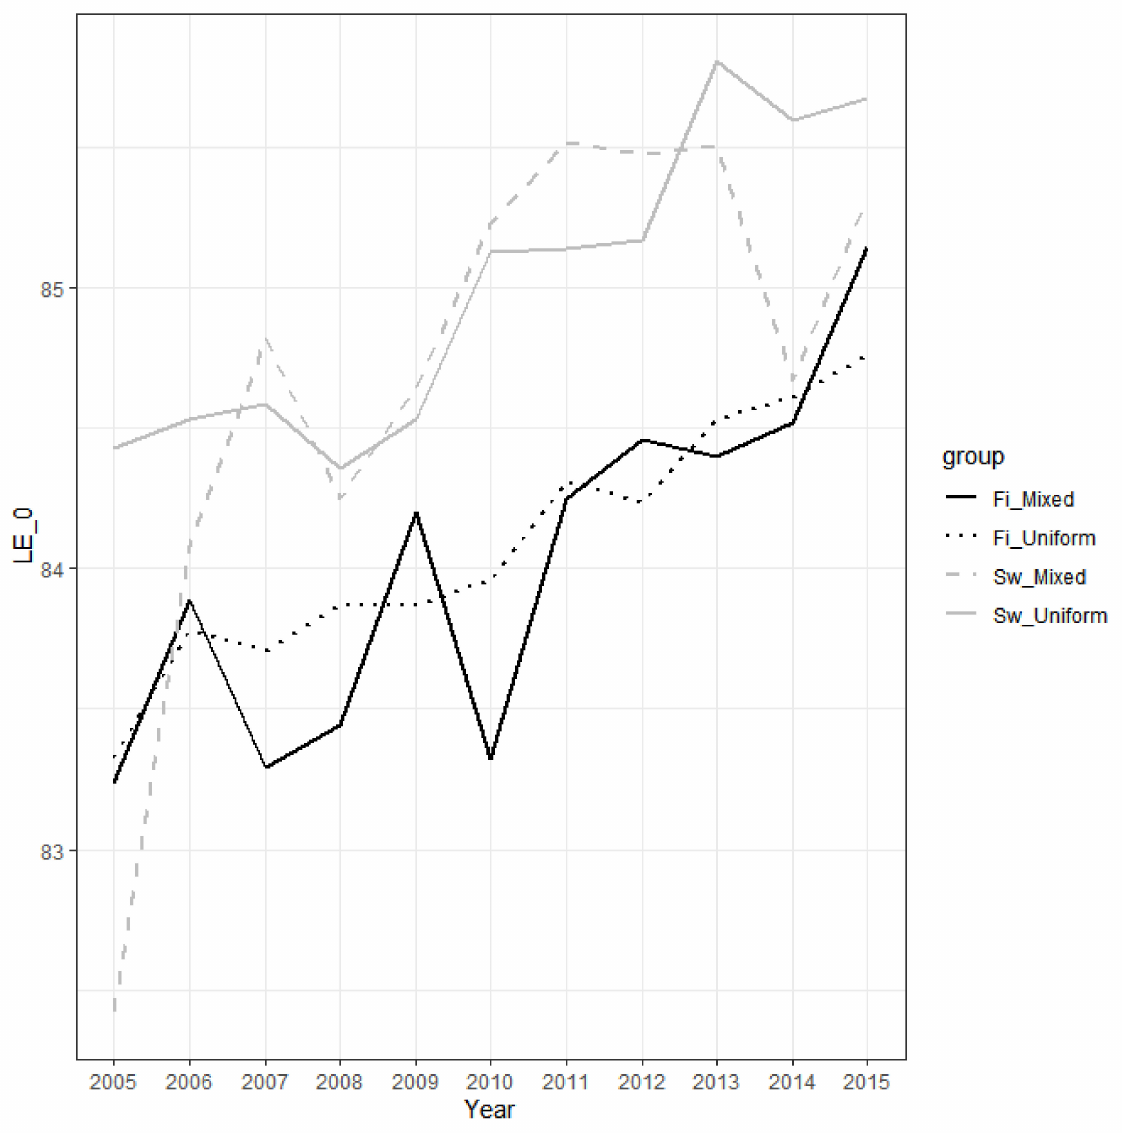
Figure 2. Female life expectancy at birth in the period 2005–2015 by own and parental ethnolinguistic affiliation. Notes: ‘Fi_Mixed’ is Finnish-registered with mixed backgrounds, ‘Fi_Uniform’ is Finnish-registered with uniform Finnish back- grounds, ‘Sw_Mixed’ is Swedish-registered with mixed backgrounds, and ‘Sw_Uniform’ is Swedish-registered with uniform Swedish backgrounds. The estimates with 95% CIs are found in Table S2 in the Supplementary Materials. LE_0 refers to life expectancy at